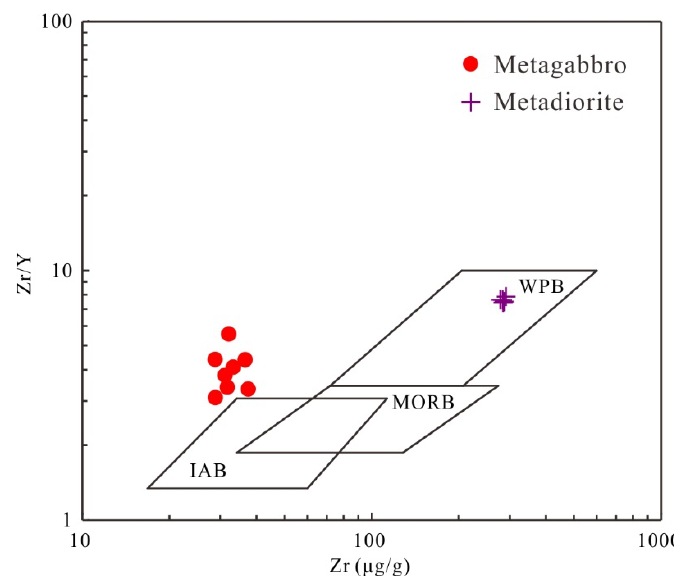
Figure 13. Zr/Y-Zr diagram for the meta-mafic rocks [98]. MORB = mid-ocean ridge basalt; IAB = island arc basalt; WPB = within plate basalt.